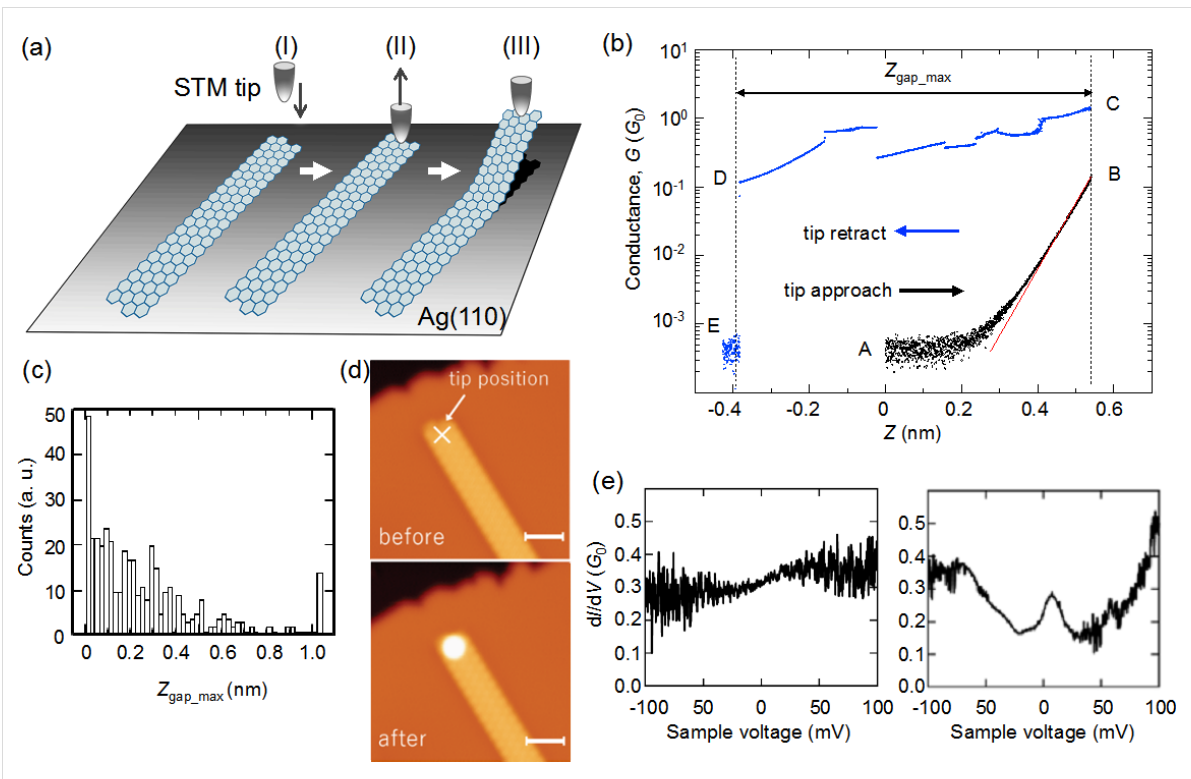
Figure 3: (a) Schematic illustration on fabrication of an SiNR nanojunction with an STM tip. (b) Conductance trace measured as a function of tip vertical position ( Z ). G 0 is the conductance quantum (7.75 × 10 − 5 S). The feedback is turned off at V S = 100 mV and I t = 20 pA and the conductance is measured at V S = 100 mV. The conductance measured during the tip approach and retraction procedures is plotted with black and blue circles, re- spectively. The red curve shows the result of the least-squares fitting. In the conductance measurement, the gain of the current amplifier is switched from 10 9 (in the STM measurements) to 10 5 for measuring the large variation of the current in the tip approach and retraction processes. The currents in the almost flat region around label A in (b) are too small to be measured with this gain so that the conductance around A is nominally different from the value (2.6 × 10 − 6 G 0 ) taken for V S = 100 mV and I t = 20 pA. (c) Histogram of Z gap_max . Z gap_max is the maximum distance the tip travels before the SiNR nanojunction is broken after contacting the tip to the SiNR. (d) STM images before and after the conductance measurement. The scale bars correspond to 2 nm. (e) Two types of d I /d V spectra of the SiNR nanojunction. The spectra are measured with a modulation voltage of 4 mV at 312.6